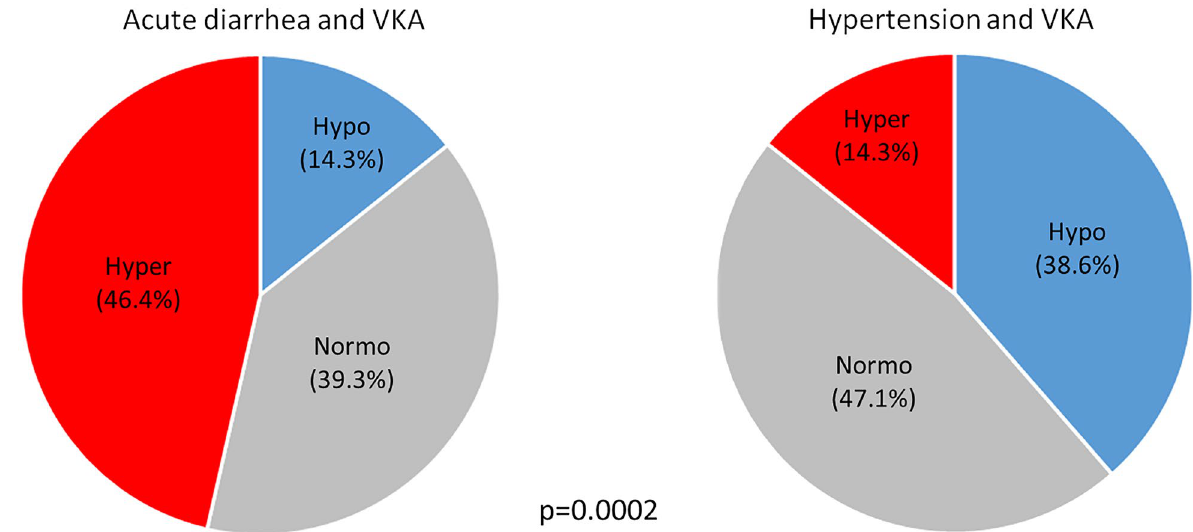
Figure 2. Proportion of subjects with vitamin K antagonists (VKA) having an INR < therapeutic range (Hypo), an INR > therapeutic range (Hyper), and within the therapeutic range (Normo) among those with acute diarrhea and the hypertensive control group. Intergroup differences in the distribution of the three categories were analyzed by Pearson Chi squared test. P < 0.05 was regarded significant.